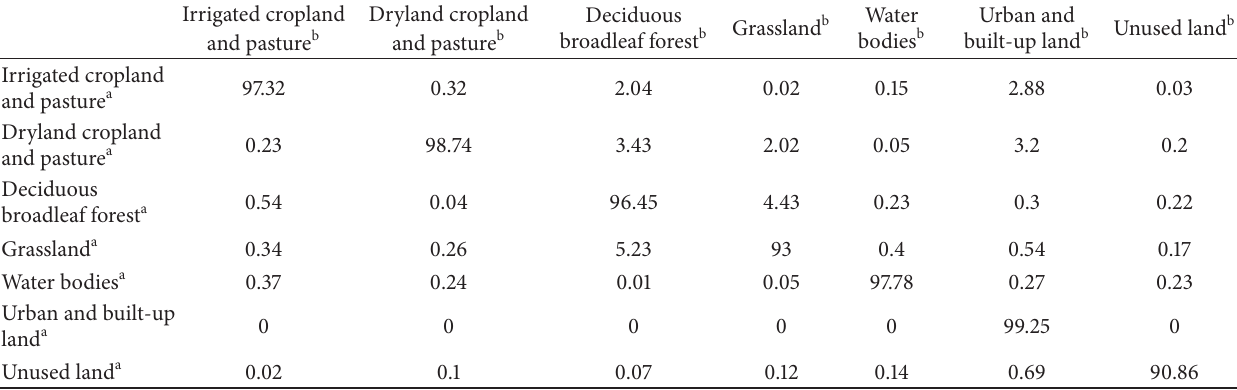
Table 5: Error matrix of accuracy assessment for reclassifying land-cover and land-use types. Irrigated